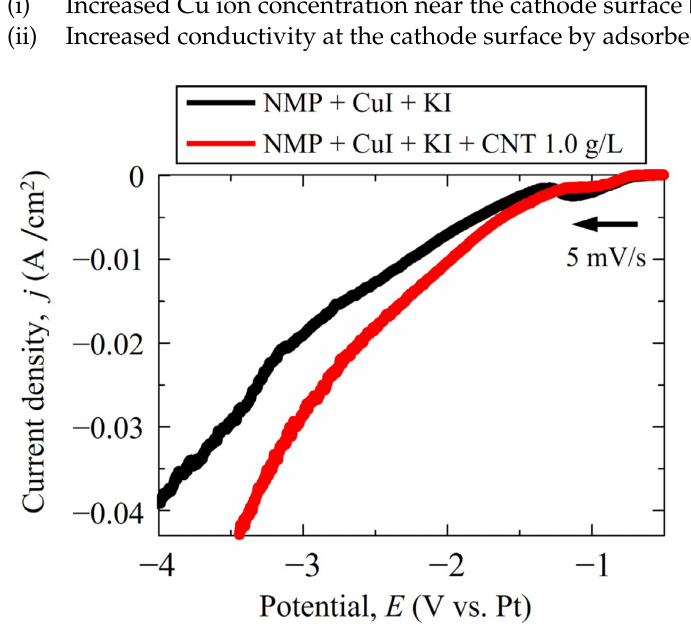
Figure 4. Cathodic polarization curves measured from Cu and Cu/CNTs